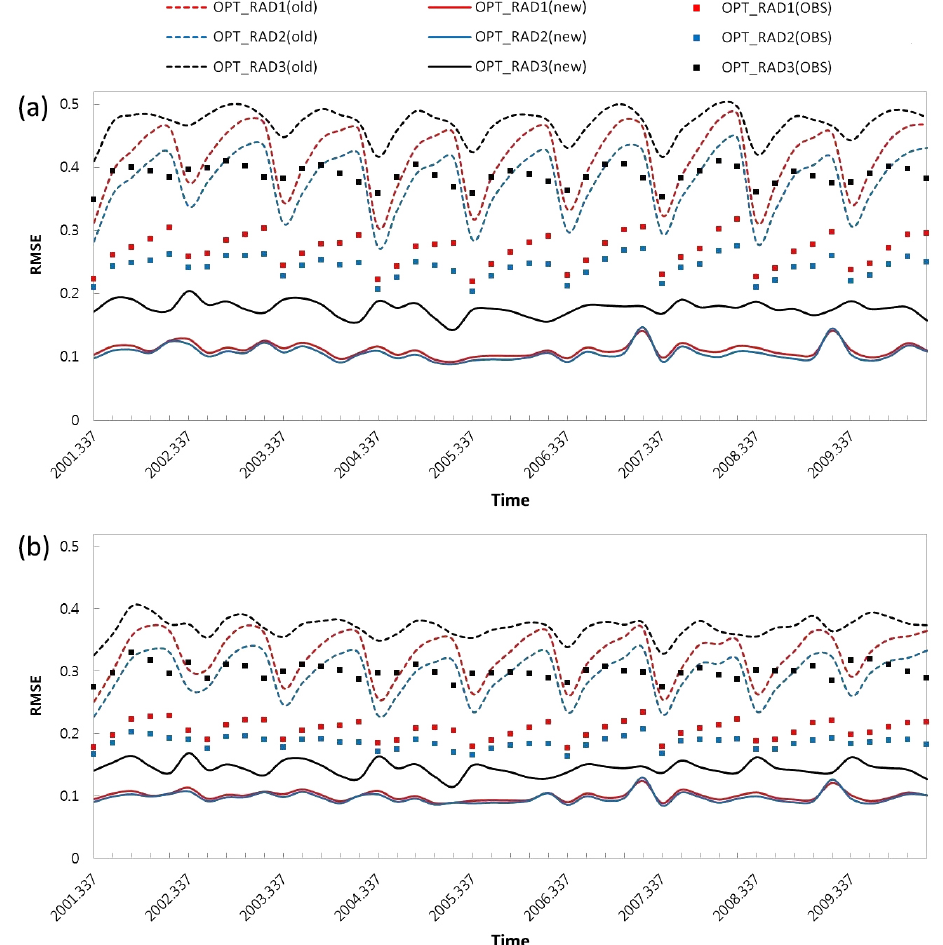
Figure 7. Comparison of RMSE values of albedo with the original minimum value of LAI and SAI (dashed lines) versus new LI and SI (solid lines) versus observed LAI and prescribed SAI (square symbols) for three radiation options for (a) BATS and (b) CLASS radiation schemes. OPT_RAD1 is MTSA, OPT_RAD2 is two-stream radiation option with no canopy gap, and OPT_RAD3 is the scheme that calculates the gap from vegetation